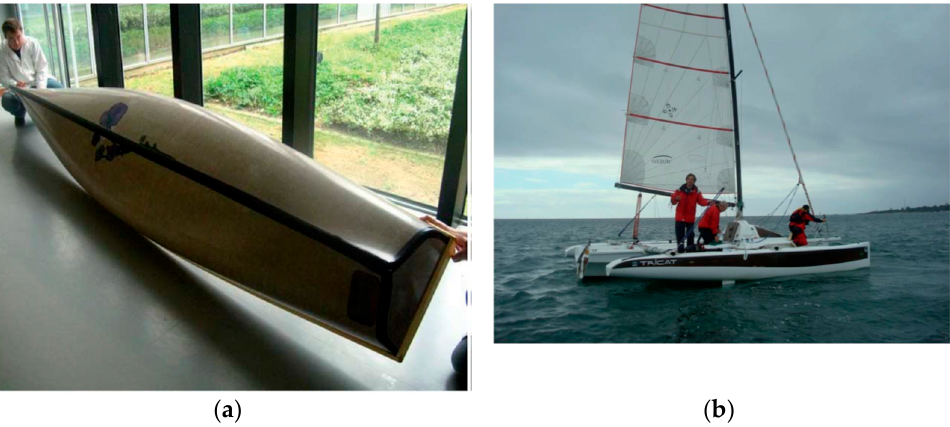
Figure 13. ( a ) Flax/PLA canoe manufactured during the NAVECOMAT project; ( b ) Gwalaz, flax fibre-reinforced trimaran [56].